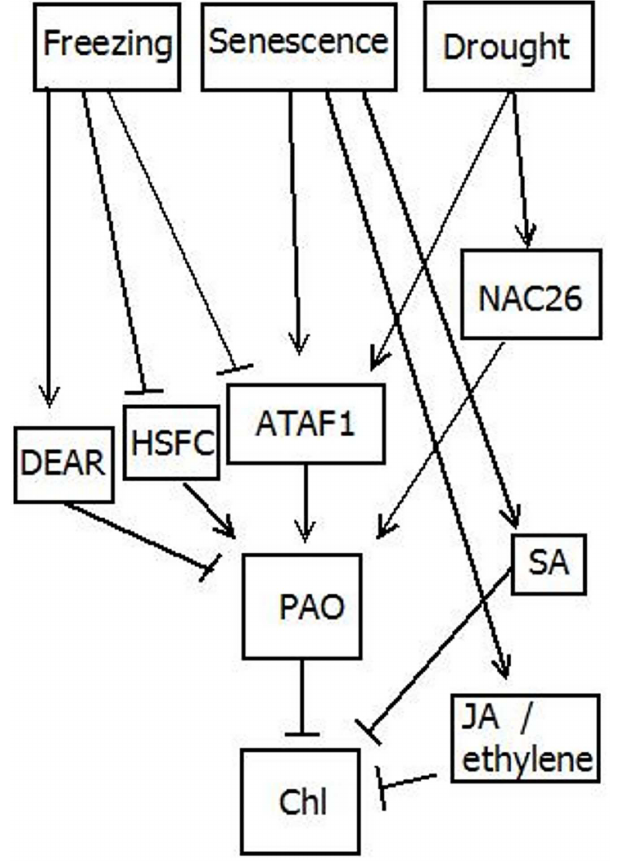
Fig 3. Schematicof regulatory relationship betweenvariousabioticandbioticfactors,ATAF1, PAO, DEAR,HSFC,and NAC26 expression,jasmonicacid(JA)/ethylene pathways, salicylicacid(SA) pathway, andchlorophyll (Chl). Theabove schematicpresentsa summaryof the findingsand ourcurrent understandingof therelationship betweenthethreedifferentconditions,cold,senescence, and drought,with ATAF1 and PAO geneexpression and chlorophyll (Chl)levels in plants.Pointed arrowsrepresent direct relationships betweentheentitieswhileblind-endedarrowsrepresent inverse relationships betweentheentities.